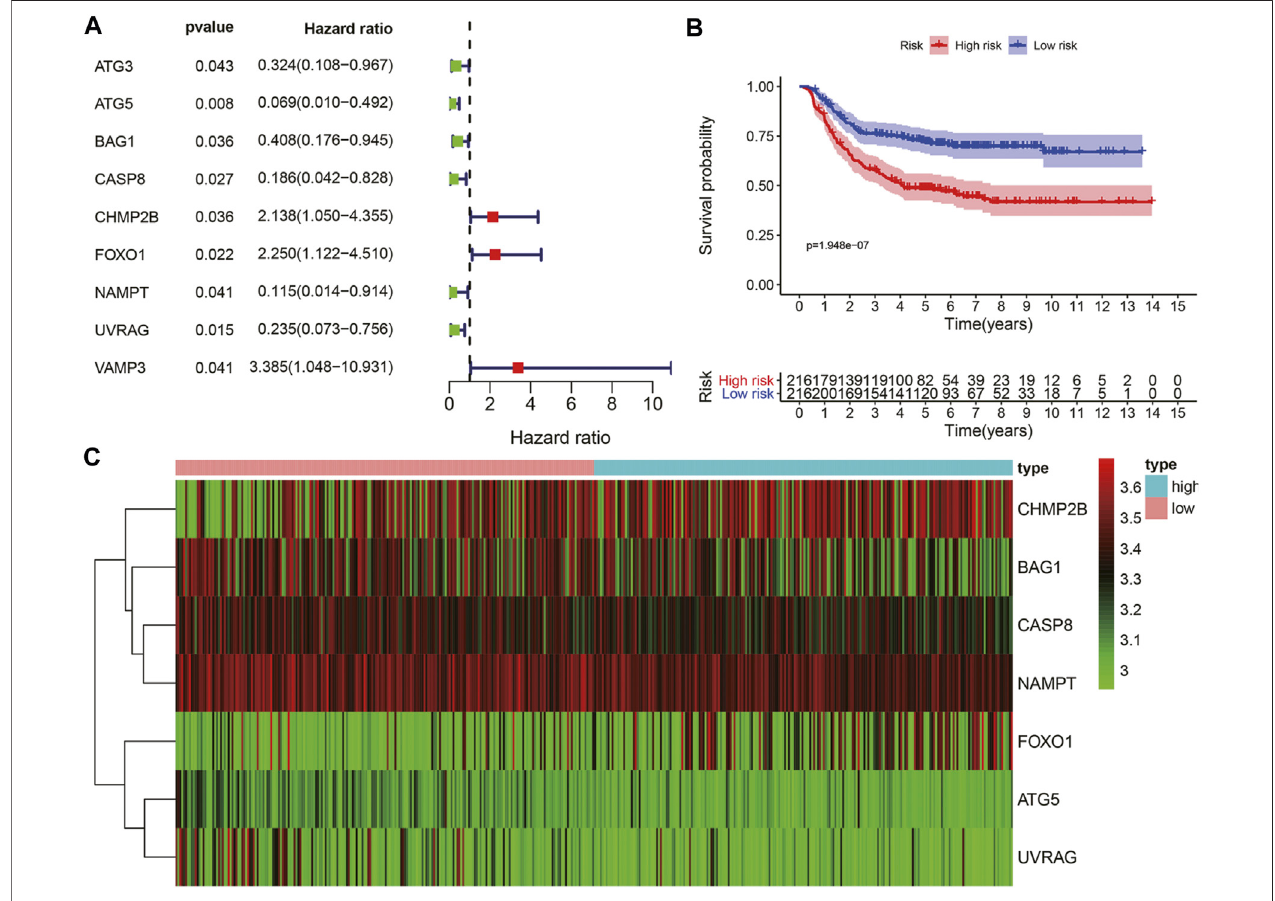
FIGURE5| TheATGsforDFSisanindependentprognosticfactorforGC. (A) UnivariateCoxregressionanalysisofautophagygenesrelatedtoDFSofGCpatients withchemotherapy. (B) Kaplan-Meier DFS curves for high and low -risk groups. (C) Theexpression ofsevenautophagy-related genesin the high and low -risk groups.